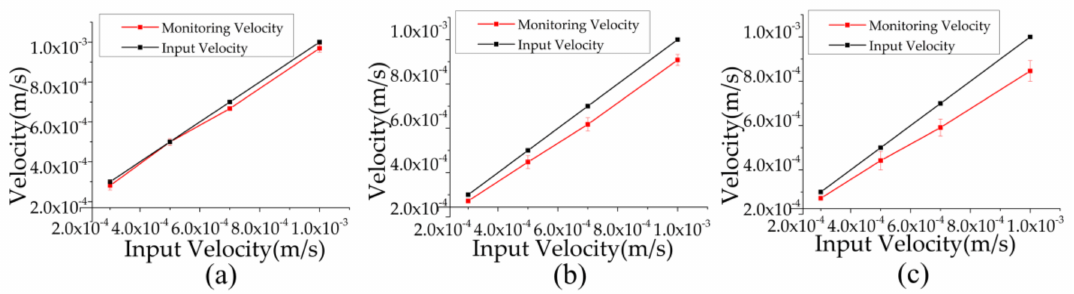
Figure 8. The comparisons of the monitoring velocity based on the decoupling mechanism and the actual input velocity in response to the vibration at the direction of 45-degree angle with the x axis in x - y plane ( a ), at a 45 degree angle with the y axis in y - z plane ( b ), and at a 45-degree angle with the x axis in x - z plane ( c ), respectively. The closed value between the monitoring results and the actual input proved the feasibility of the monolithic structure and the decoupling